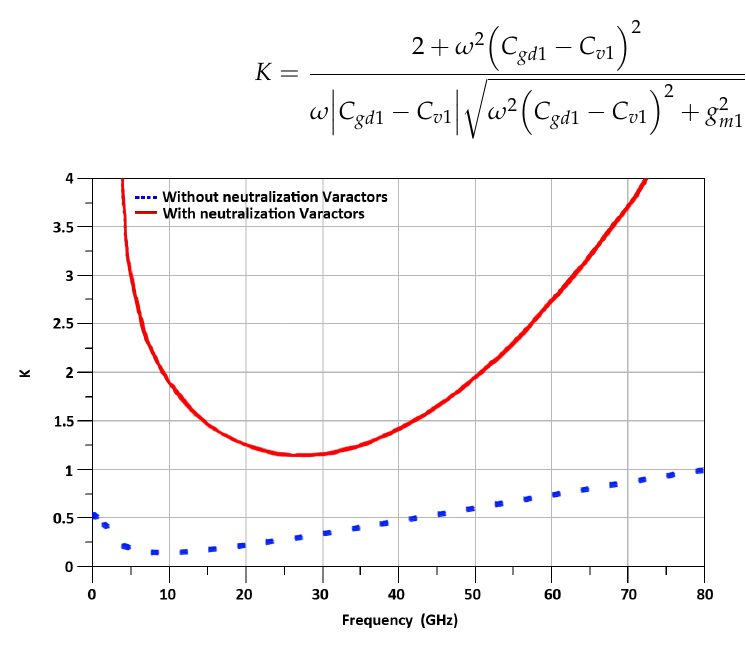
Figure 9. Stability Factor K. Equation (1) shows that when varactor’s capacitance C v1 is equal to C gd1 , the stability factor is maximum. As we use a varactor’s capacitance, to neutralize the C gd , which can be controlled externally, the PVT variations do not affect the stability of M 1 . The simulated varactor capacitance versus the voltage, V t , is shown in Figure 10. The gain, G, of TCC-CS of the transconductance stage is expressed in Equation (2) and the calculated result of G versus the varator capacitance is shown in Figure 11.